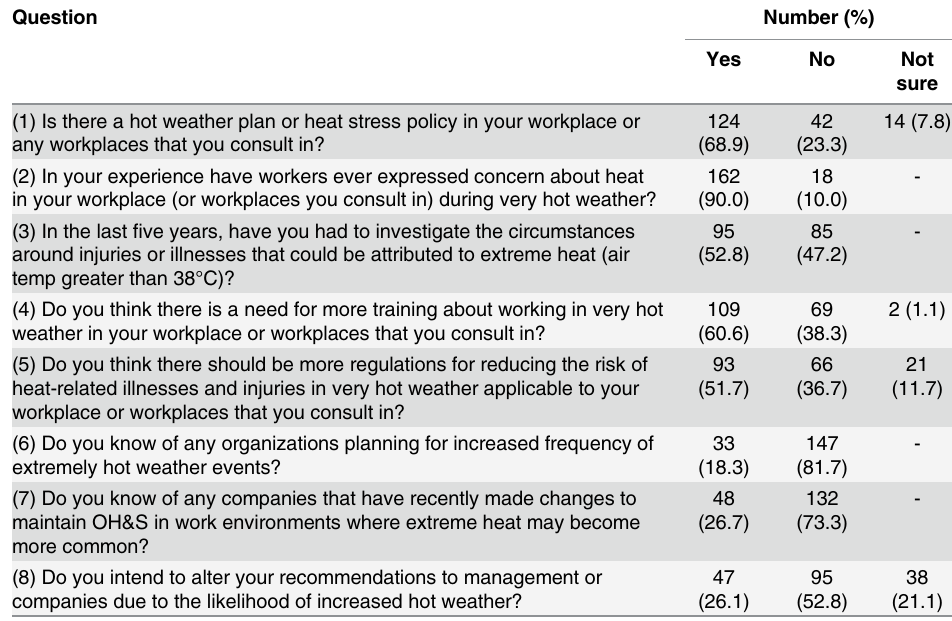
Table 4. Number and percentage of extreme heat preparedness and management.